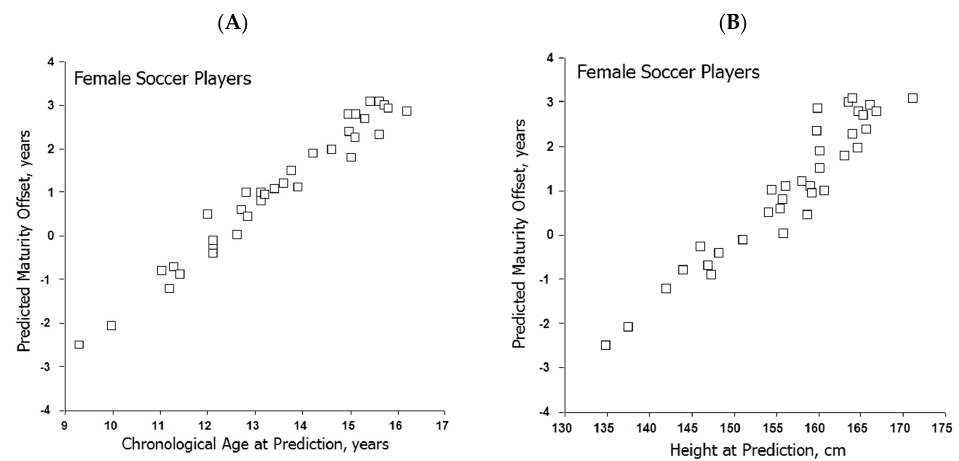
Figure 3. Means for predicted maturity offset (MO) in samples of female soccer players plotted relative to ( A ) mean chronological age and ( B ) mean height. References for the studies of soccer players are indicated in Supplementary Table S1: 2010–2017: [60–65]; 2018–2020: [58–68].